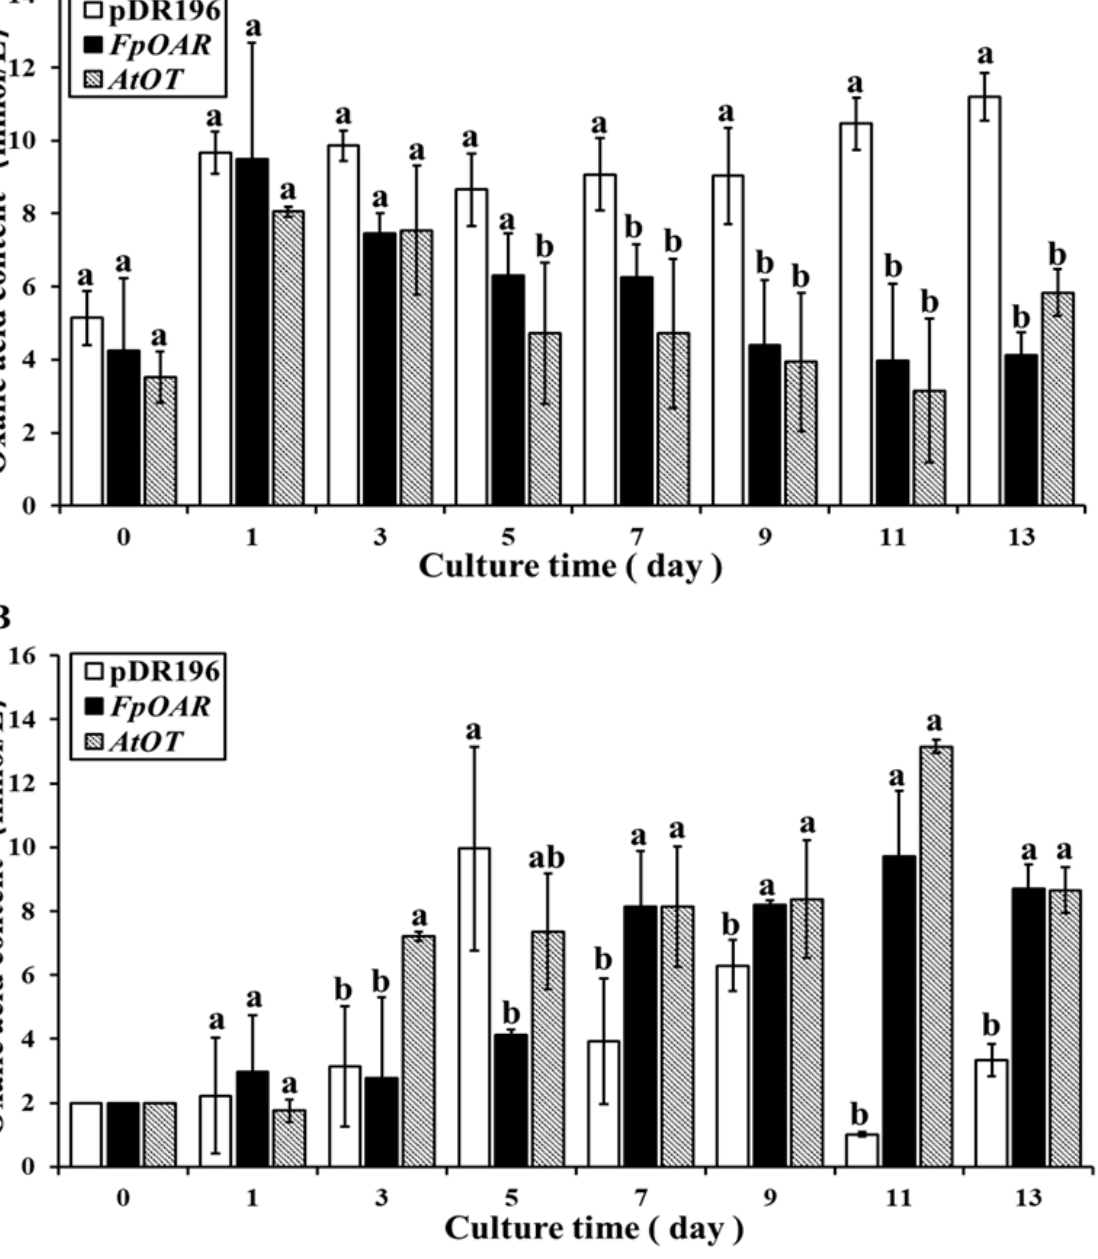
Figure 6. Changes in oxalic acid contents in the medium and cells of the yeast transformants under 2 mmol/L oxalic acid stress. ( A ) Changes in oxalic acid contents in the yeast transformants under 2 mM oxalic acid stress. ( B ) Changes in oxalic acid contents in the culture medium under 2 mM oxalic acid stress. Different letters indicate significant differences among different recombinant yeast cells at p < 0.05.